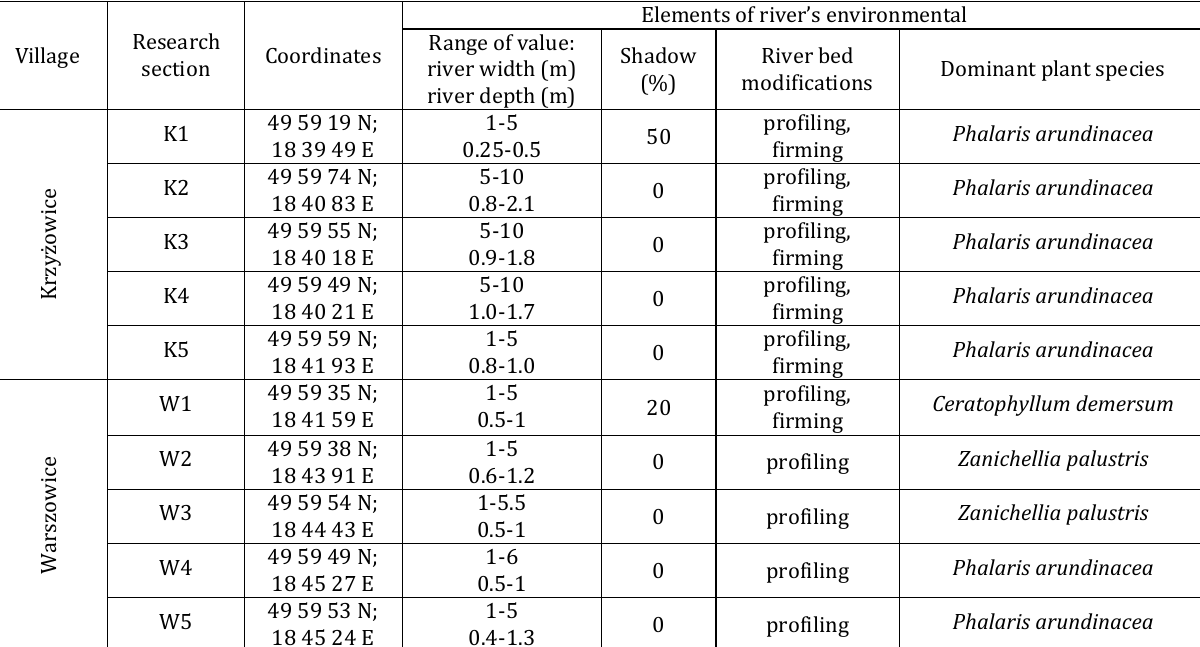
Table 1. The scale of the degree of the bottom coverage by macrophytes (after: Szoszkiewicz et al., 2010) Percentage share in coverage Coefficient of coverage Table 2. Description of abiotic conditions at the research section (author's research)